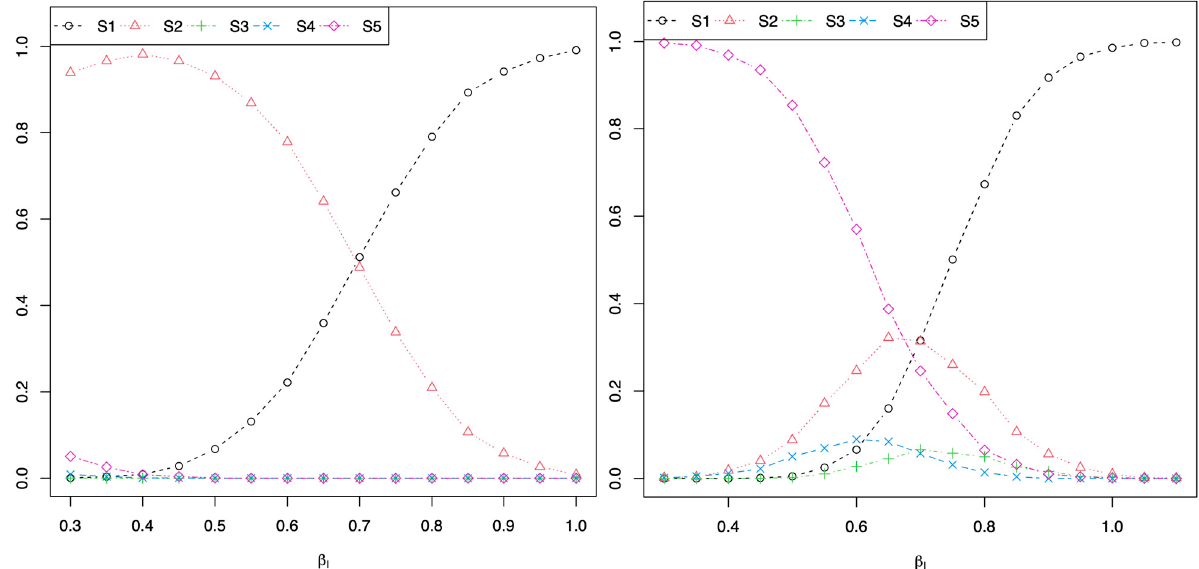
Figure 1. β 1 = 0.3 and β 2 = 0.3 in Equation (2) for the plot on the left and β 1 = 0 and β 2 = 0 in Equation (2) for the plot on the right, where both y-axes are the proportion of simulations where the null hypothesis was rejected. For the plot on the left, when the interaction was simulated to be weaker (i.e., β I closer to 0.3 in Equation (2)), the majority of simulations concluded scenario 2: rejecting Algorithm 0 H 0 : δ 1 = 0 and Algorithm 1 H 0 : α 1 = 0, but failing to reject H 0 for Algorithm 2 (i.e., there was not a signification SNP by SNP interaction). For the plot on the right, when the interaction was simulated to be weaker (i.e., β I closer to 0.3 in Equation (2)), the majority of simulations concluded scenario 5: failing to reject Algorithm 0 H 0 : δ 1 = 0 (i.e., the SNP X 1 was not associated with the trait of interest Y). For both plots, when a stronger interaction between the 2 SNPs was simulated (i.e., β I closer to 1 in Equation (2)), the majority of simulations concluded scenario 1: rejecting Algorithm 0 H 0 : δ 1 = 0, Algorithm 1 H 0 : α 1 = 0, and Algorithm 2 H 0 : ϕ I =